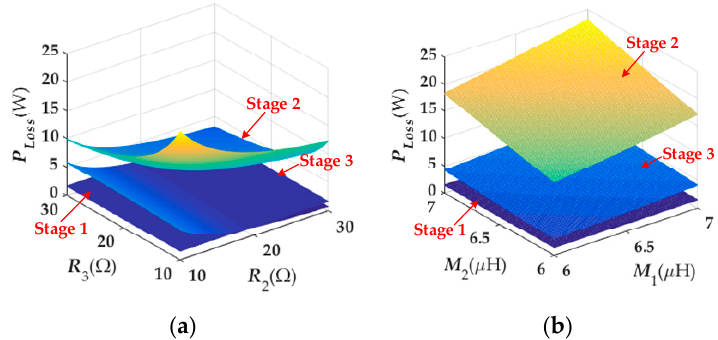
Figure 9. The variation of the loss P Loss with the loads and the mutual inductances in Mode A. ( a ) The variation of P Loss with R 2 and R 3 ; ( b ) the variation of P Loss with M 1 and M 2 .